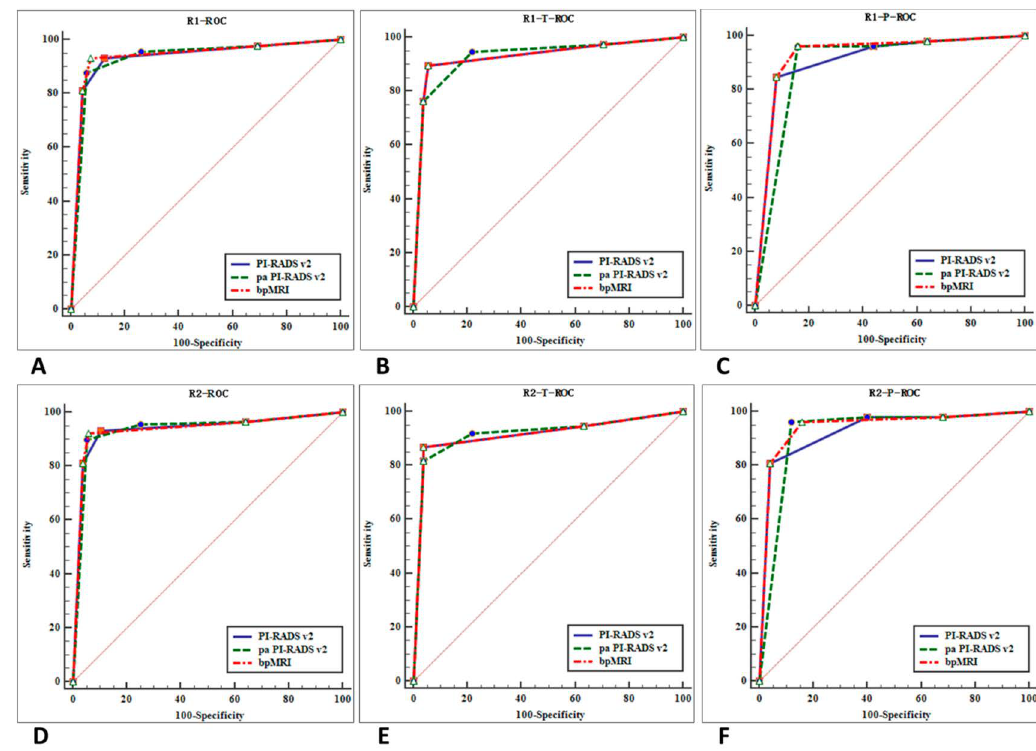
Figure 5. ROC curves for the diagnostic performance of two reviewers who used the three protocols. ROC curves of reviewer 1 for the diagnosis of prostate cancer (TZ + PZ) ( A ), prostate cancer in TZ ( B ), and PZ ( C ). ROC curves of reviewer 2 for the diagnosis of prostate cancer (TZ + PZ) ( D ), prostate cancer in TZ ( E ), and PZ ( F ).